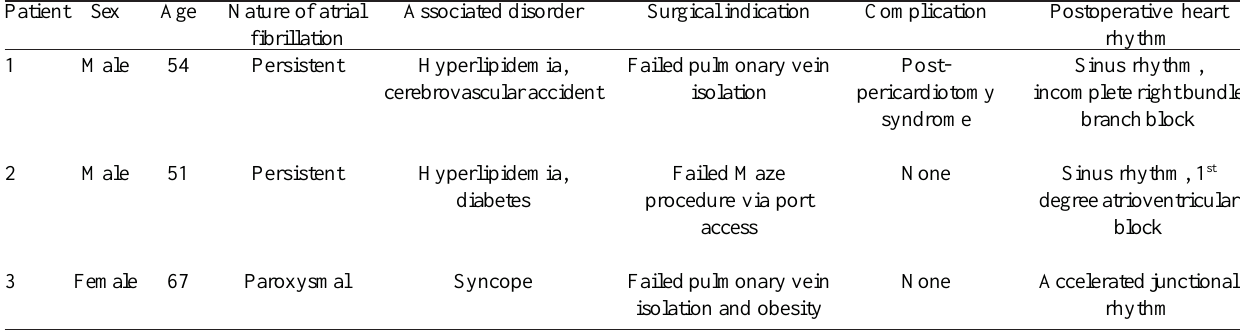
Table 1. A comparison of the clinical features of the patients undergoing open-chest Maze procedure.